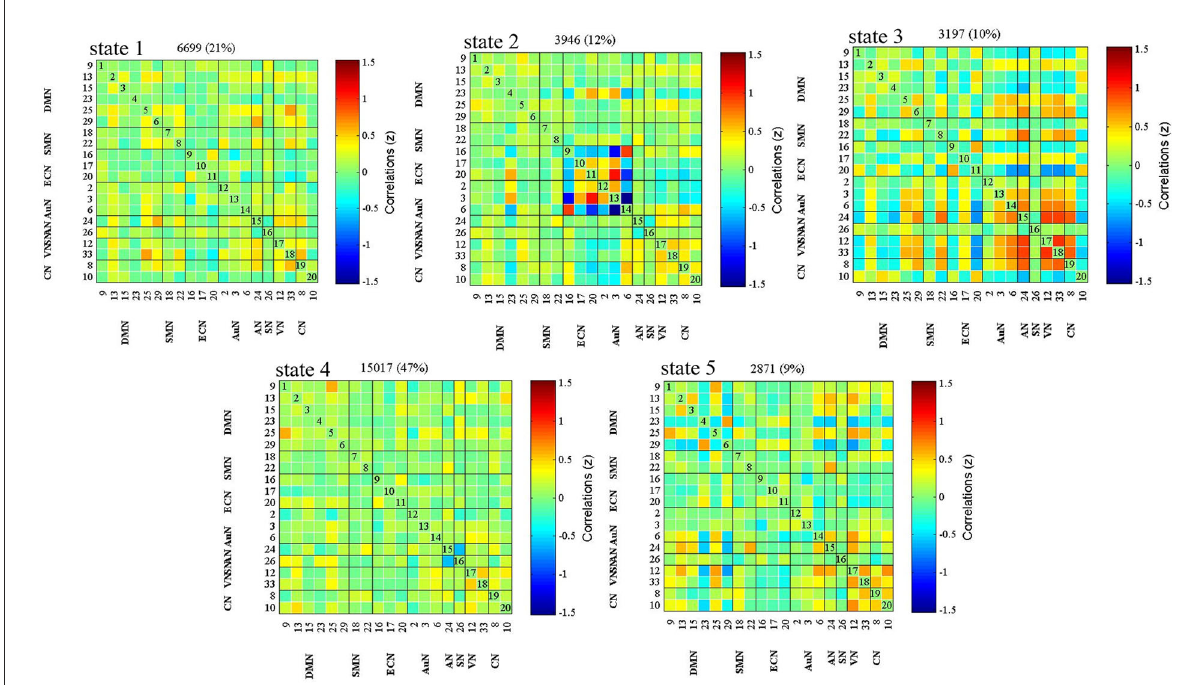
FIGURE2 Dynamic functional network connectivity (dFNC) centroids obtained for the five states using the k -means algorithm. The total number of occurrences and percentage of total occurrences are listed above in each cluster median.